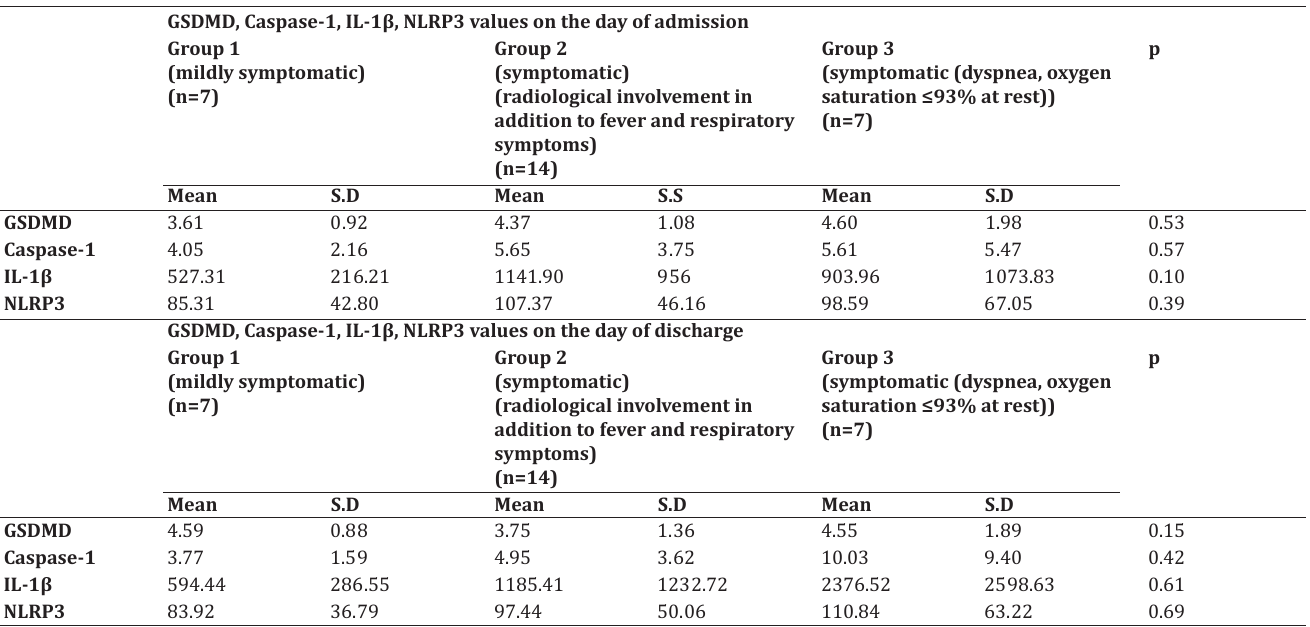
GSDMD, Caspase-1, IL-1 β , NLRP3 values on the day of admission and discharge days